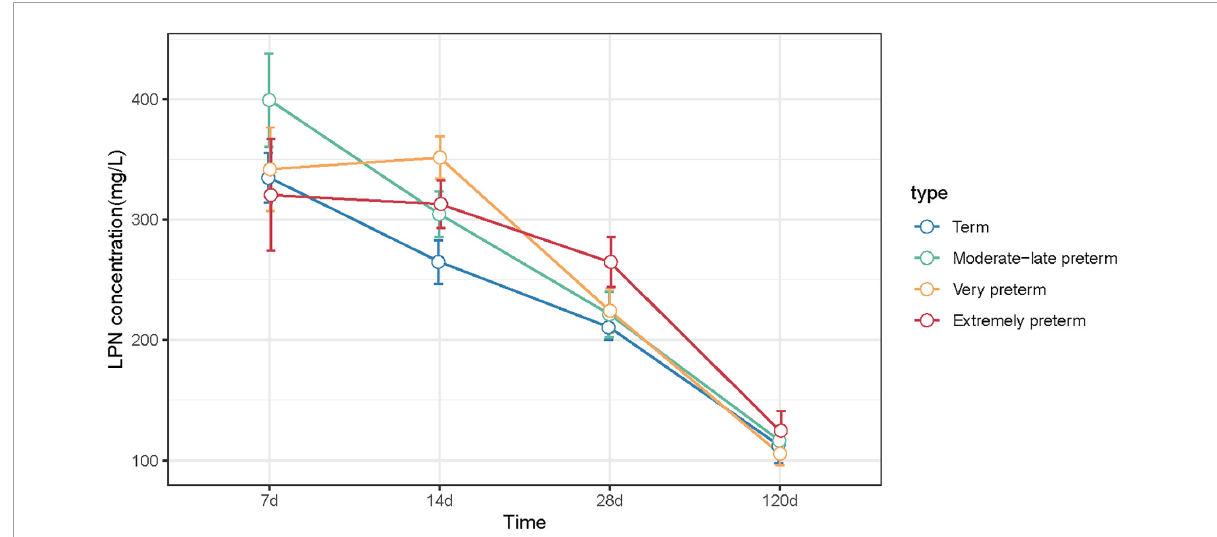
FIGURE2 LPN concentrations of term, MPT, VPT, and EPT milk at 7, 14, 28, and 120 days postpartum. Statistical differences compared to term group were indicated by * P < 0.05, ** P <